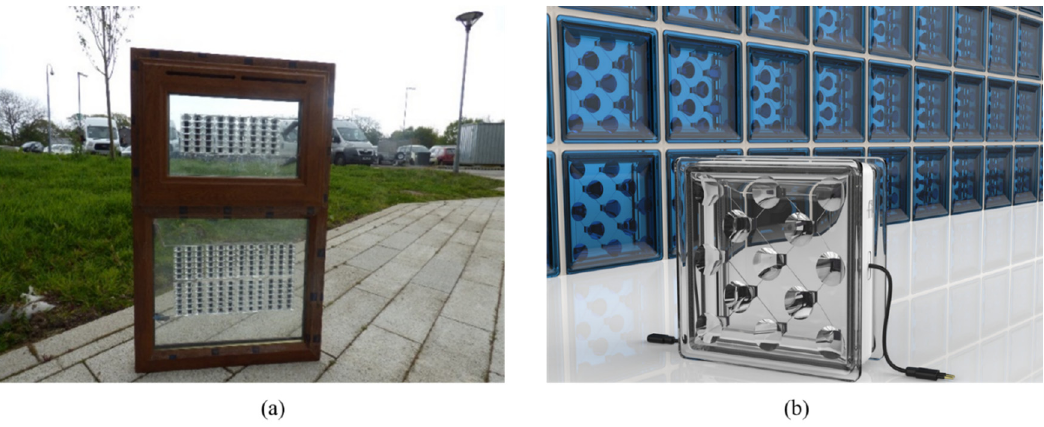
Figure 3. ( a ) CPC based BIPV, ( b ) Semi-transparent building blocks using CPC-silicon PV (image courtesy Build Solar).